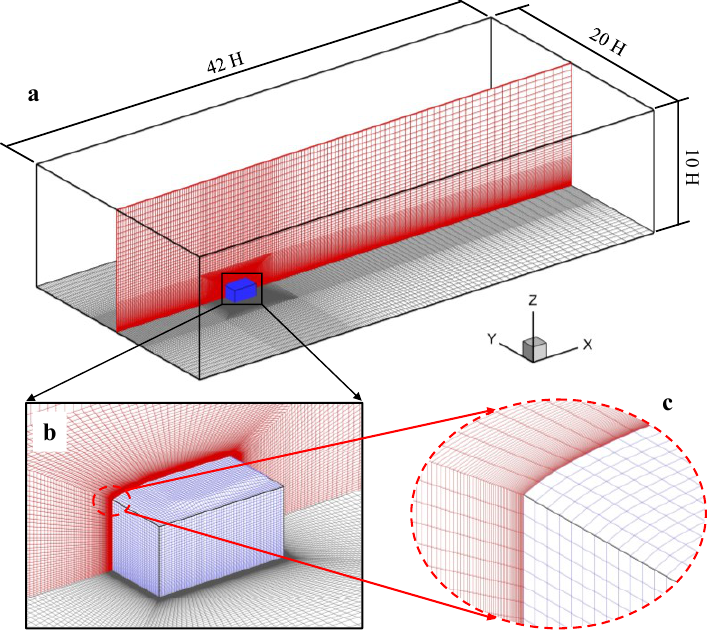
Figure 3. Schematic view of domain size and grid configuration (( a ) computational domain size; ( b , c ) enlarged view of mesh schematic).